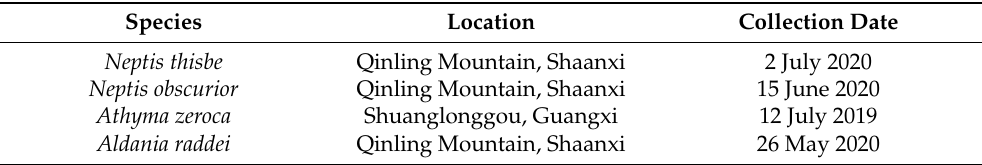
Table 1. The voucher information of the specimens used for mitochondrial genomes sequencing in this